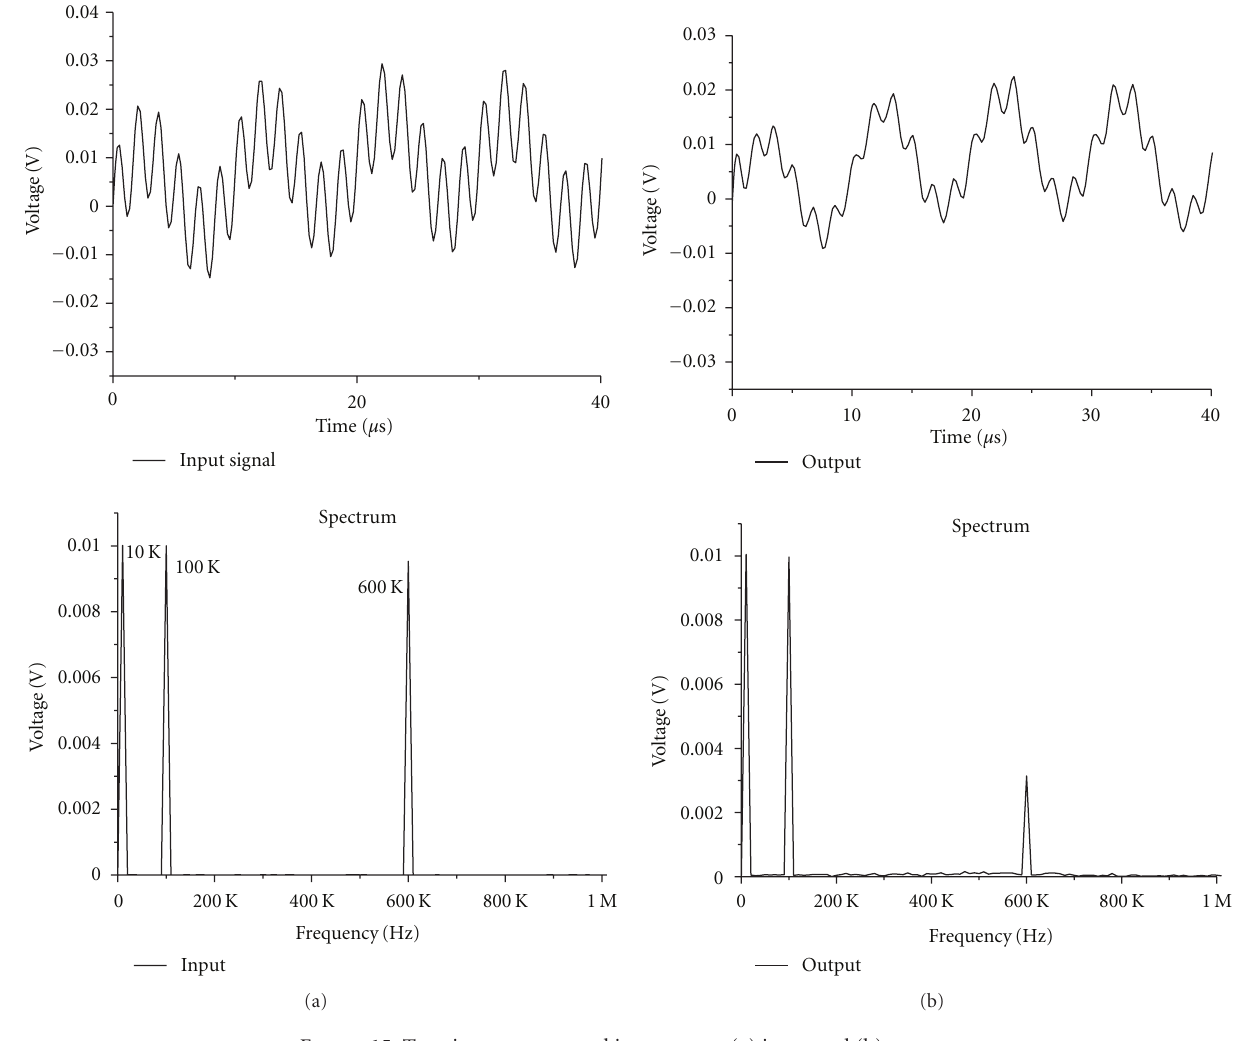
Figure 15: Transient response and its spectrum (a) input and (b) output.